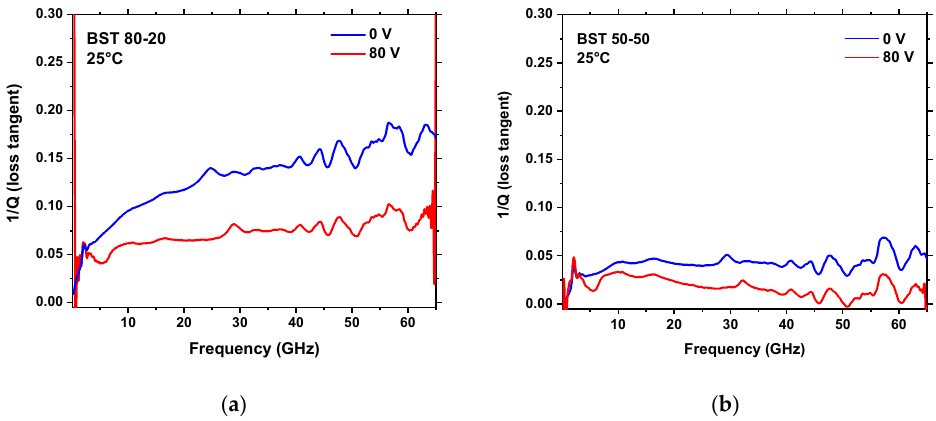
Figure 4. Overall losses of IDC devices integrating BST 80–20 ( a ) and BST 50–50 ( b ) for 0 V and 80 V applied bias.